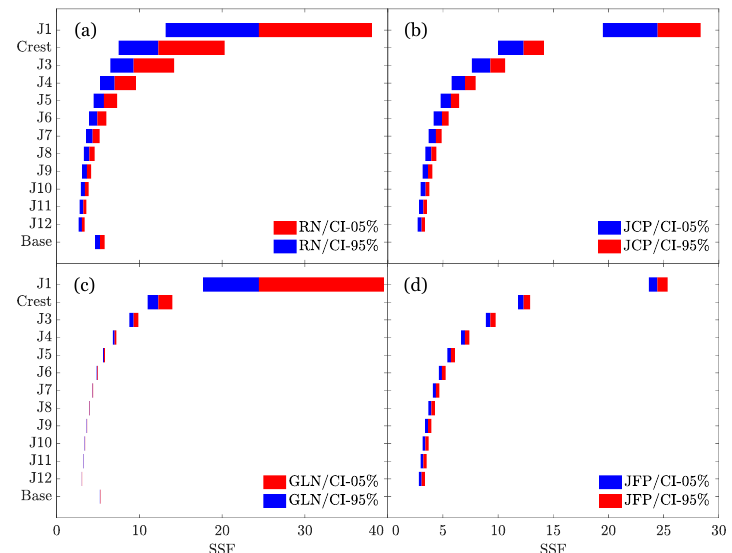
Figure 5. Joint TD for the SSF: ( a ) reservoir elevation (RN), ( b ) joint peak cohesion (JCP), ( c ) ice load (GLN), and ( d ) peak friction angle (JFP).